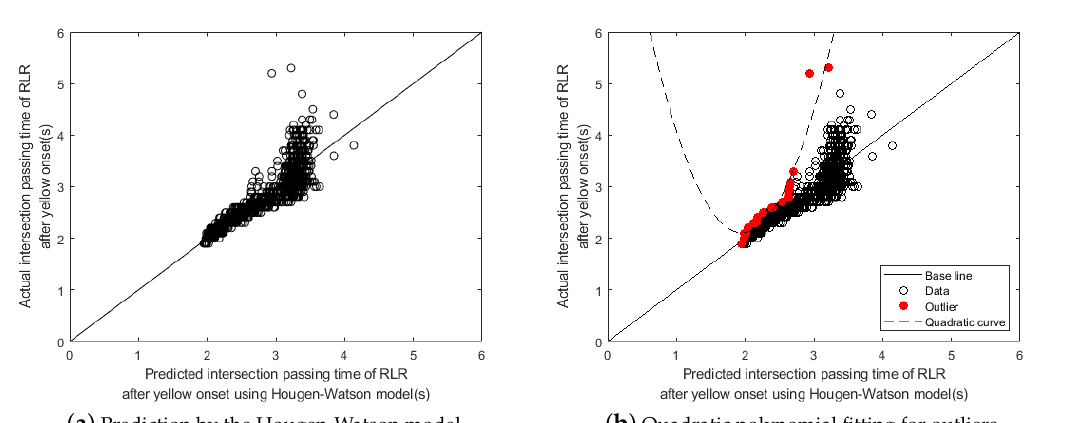
Figure 8. All-red signal extension time for RLRs: Actual vs.